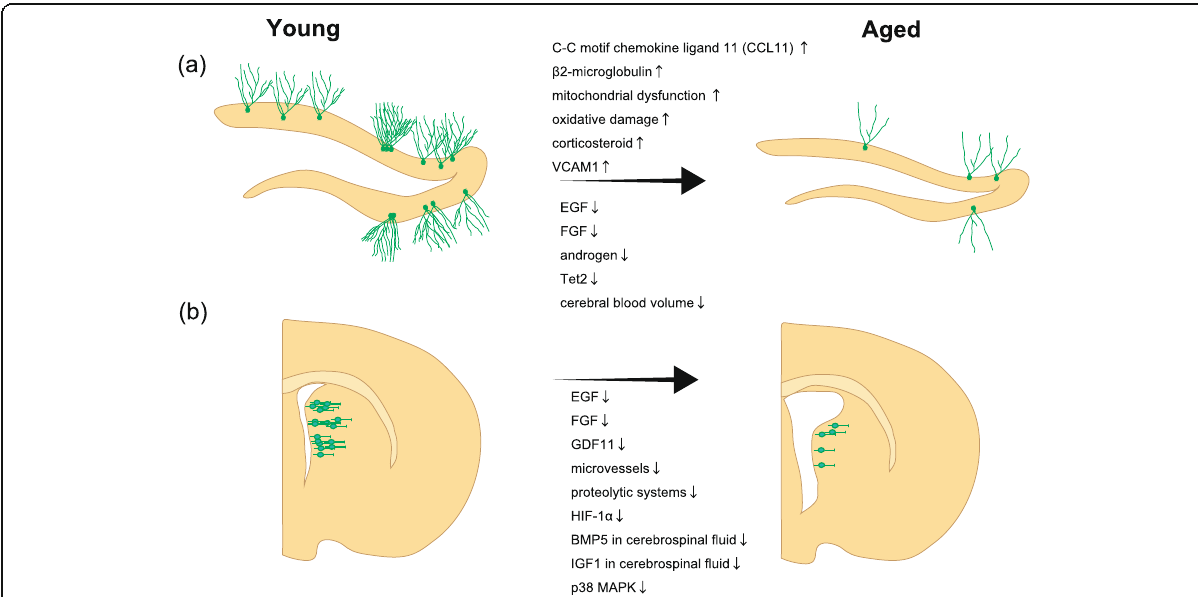
Fig. 1 Various factors related to the decrease in adult neurogenesis with aging. Representative factors that decrease adult neurogenesis with age in the SGZ ( a ) and V-SVZ ( b